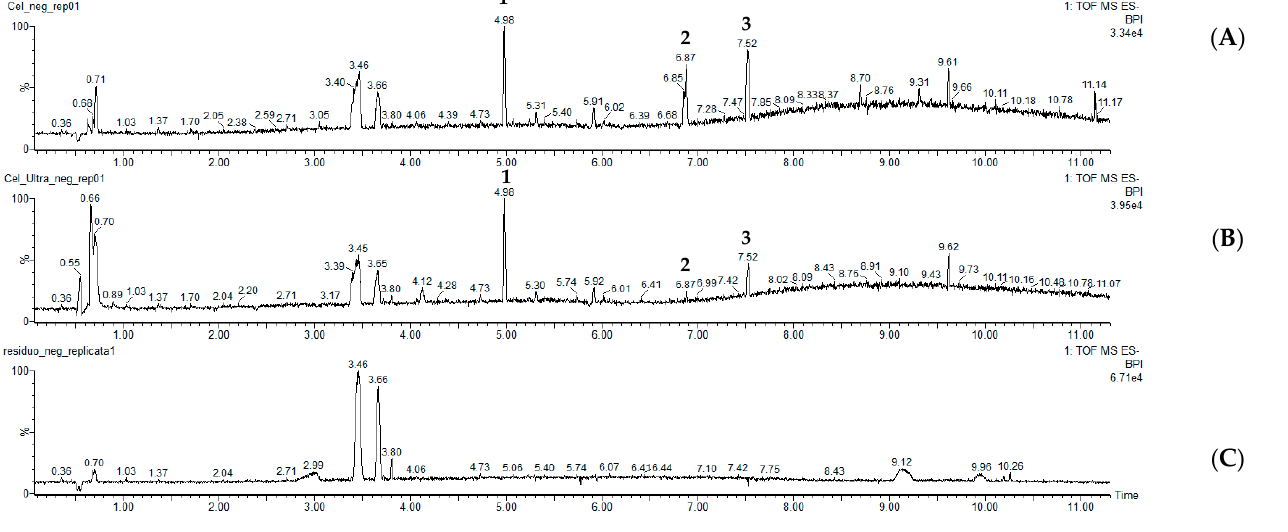
Figure 2. Representative UHPLC-ESI-QTOF-MS chromatograms of C. erecta extracts in the negative mode. ( A ) UHPLC-ESI-QTOF-MS chromatogram of the crude C. erecta extract without ultrafiltration; ( B ) representative UHPLC-ESI-QTOF-MS chromatogram of the ultrafiltrates of C. erecta extract after incubation with potato apyrase; ( C ) UHPLC-ESI-QTOF-MS chromatogram of the blank control group (ultrafiltrates of solvent with potato apyrase). The main screened potential apyrase ligands are marked with numbers above the peaks.